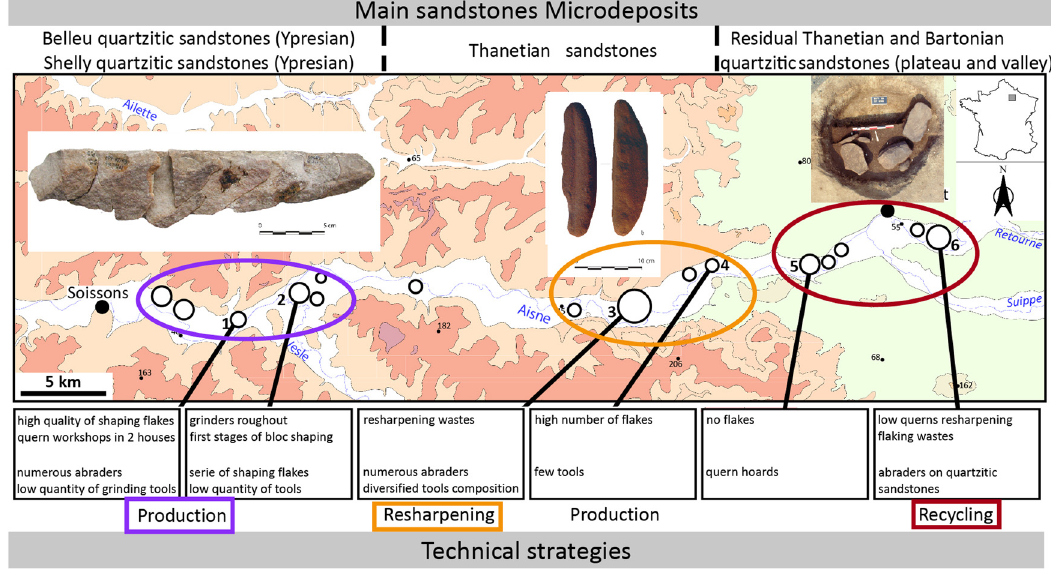
Figure 5: Schematic organization of sandstone supply and management on LBK sites, in relation to the availability of micro - deposit sandstones in the geological layers along the Aisne valley ( revised after Hamon & Fronteau, 2018 ) . ( a ) First shaping sequence of a sandstone block in Missy - sur - Aisne, ( b ) example of an abrader of glauconious thanetian sandstone from Cuiry - les - Chaudardes, and ( c ) quern hoard from Berry - au -